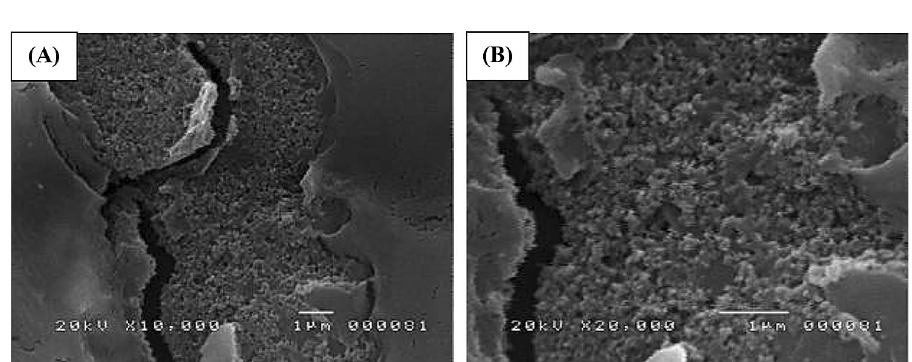
Figure 13. SEM micrographs of the modified SPGE at magnifications of ( A ) ×10,00 and ( B ) ×20,000